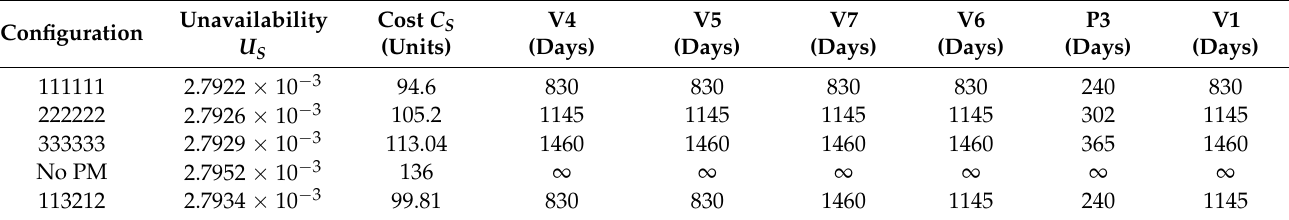
Table 4. Decision variable vectors ( TP 1 , . . . , TP k ) for the configurations of the full system Table 3. Decision variable vectors (𝑇𝑃 1 ,… , 𝑇𝑃 𝑘 ) for the configurations of system Version 2.